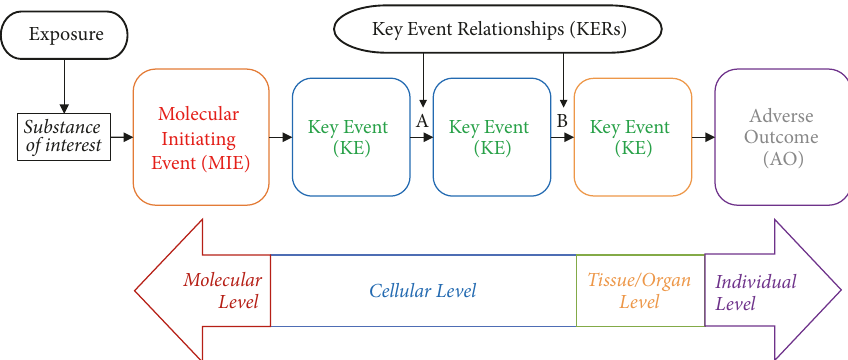
Figure 1: A schematic representation of the adverse outcome pathway (AOP). An AOP starts with a molecular initiating event (MIE) which is triggered by exposure to a substance of interest that interacts or reacts with a biological target, often a molecule. This MIE leads to a sequential series of intermediate key events (KE) along the different levels of biological organization to produce an adverse outcome (AO). A and B represent the relationships between two unique key events (KERs).